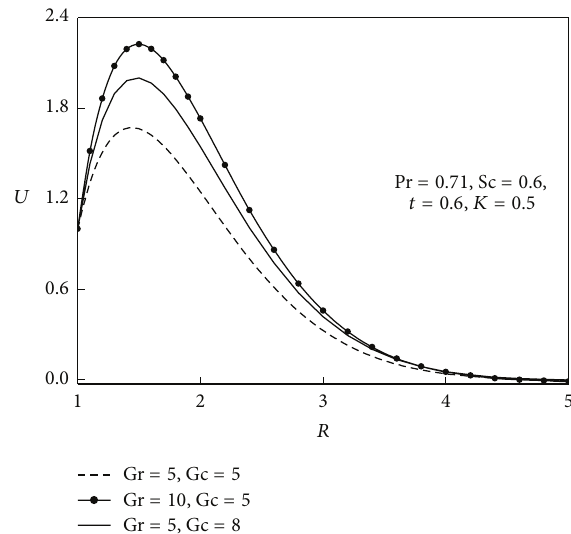
Figure 2: Velocity profiles for different 𝐾 and Pr at Gr = 5, Gc = 5, 𝑡 = 0.6 , and Sc = 0.6.